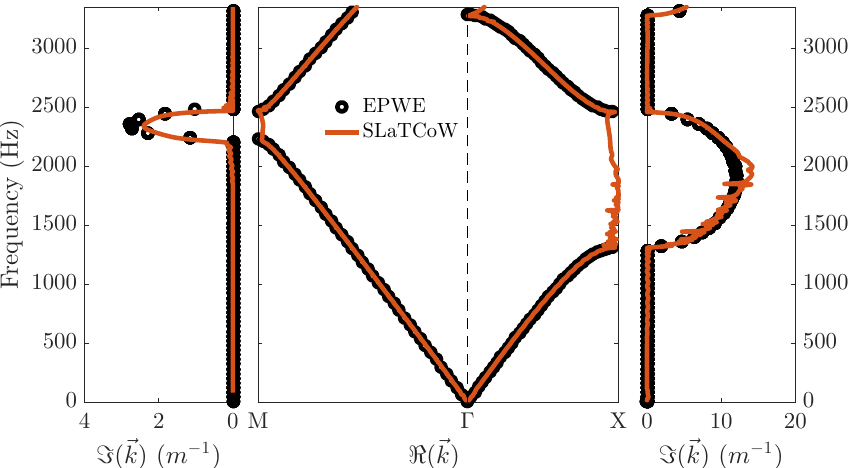
Figure 3. Complex dispersion relation for a SC composed of rigid cylinders arranged in a square lattice. Numerical results obtained for a N × N finite structure are compared to the ones obtained using EPWE for the same periodic structure having infinite